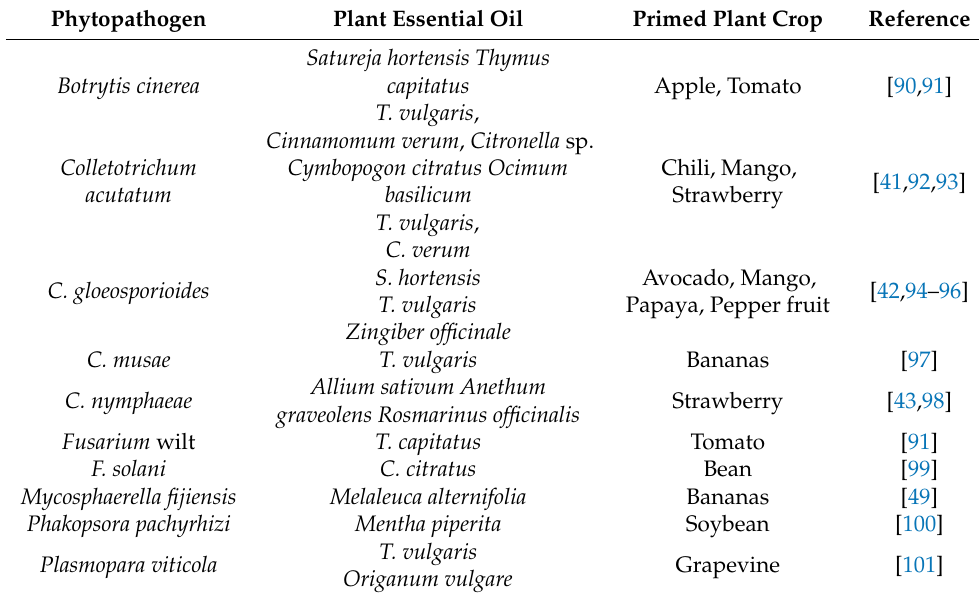
Table 1. List of essential oils with reported priming